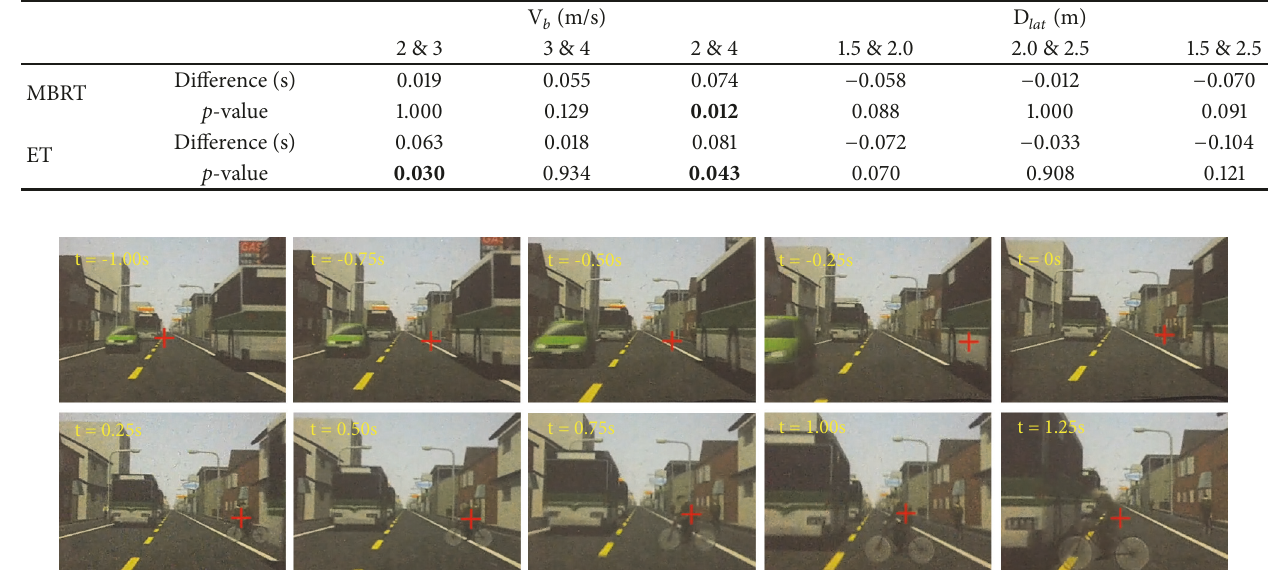
SD=8.5), whose driving experience varied from 3 to 15 years (Mean=7.2, SD=3.4) participated in the experiment.